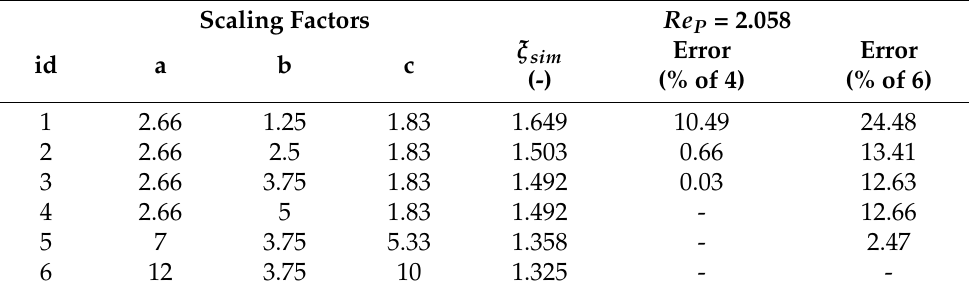
Table A1. Domain size study of synthetic cluster cases.